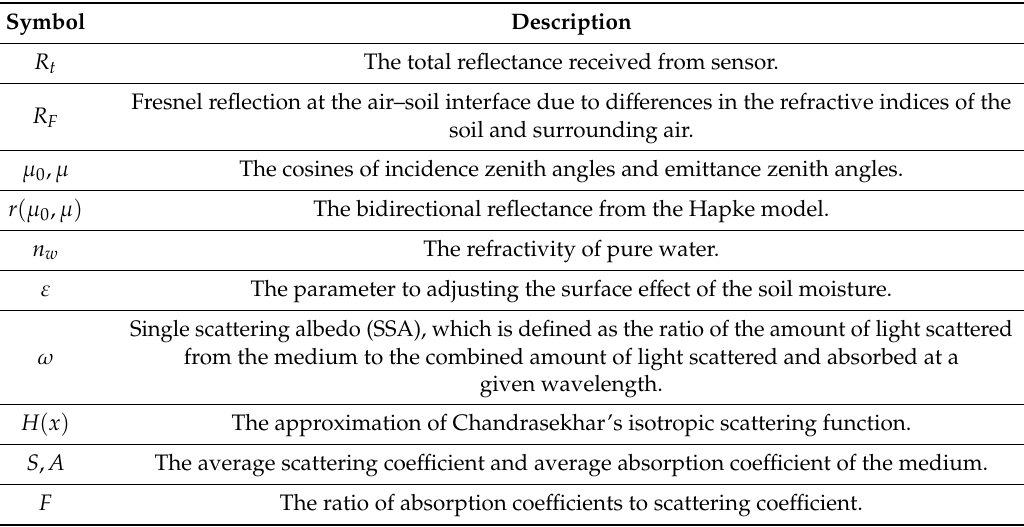
Table 2. Description of the parameters of SMR–Hapke